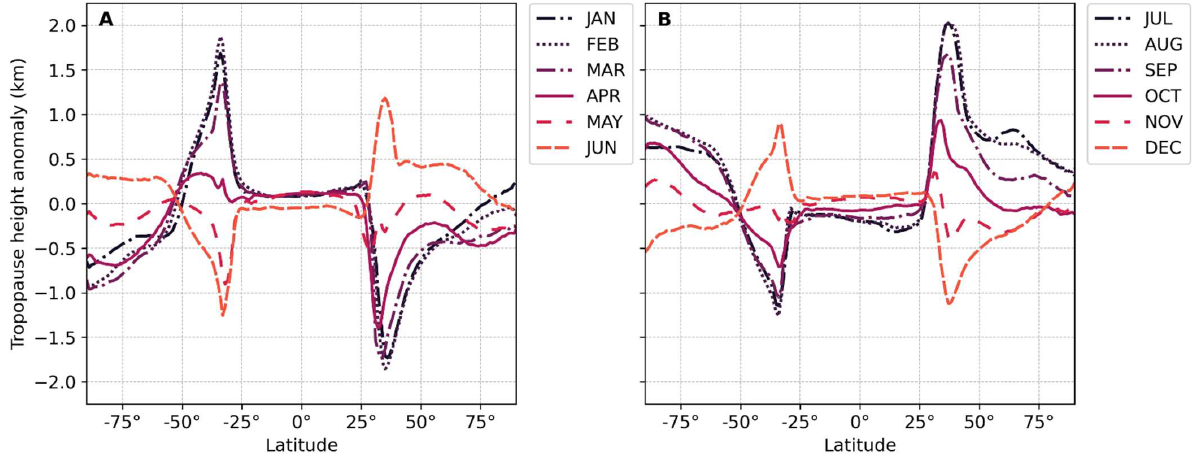
Figure 3. Mean zonal tropopause anomalies. Panel ( A ) from January to June (using the 3.5 PVU surface as reference). Panel ( B ) from July to December. By calculating the anomalies, we first averaged the corresponding months (for example, every month of January in the 41 years), from which we subtracted the average of the entire period.